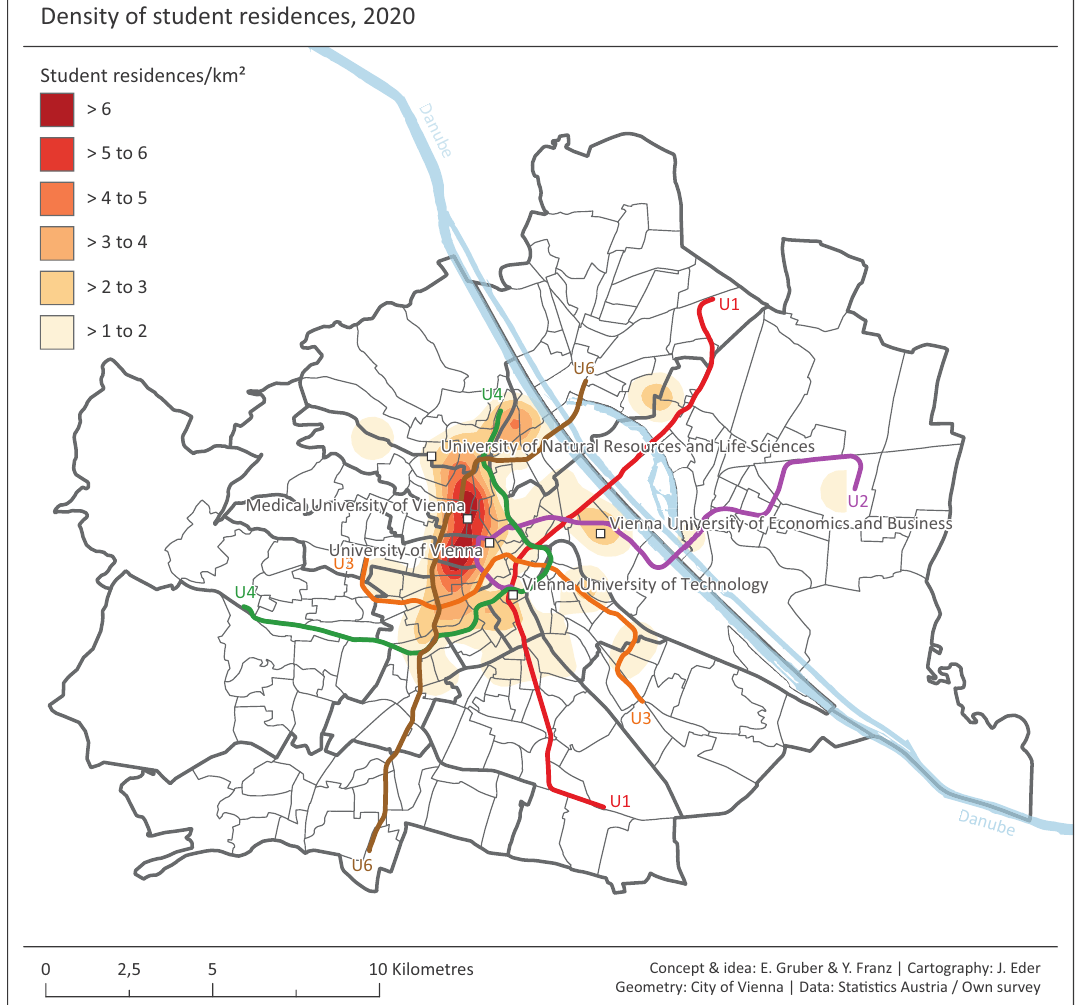
Figure 1. Localising student accommodation in Vienna: Density map (student residences per km²,